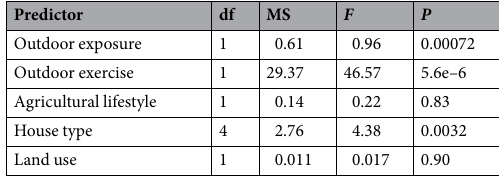
Predictor df MS F P